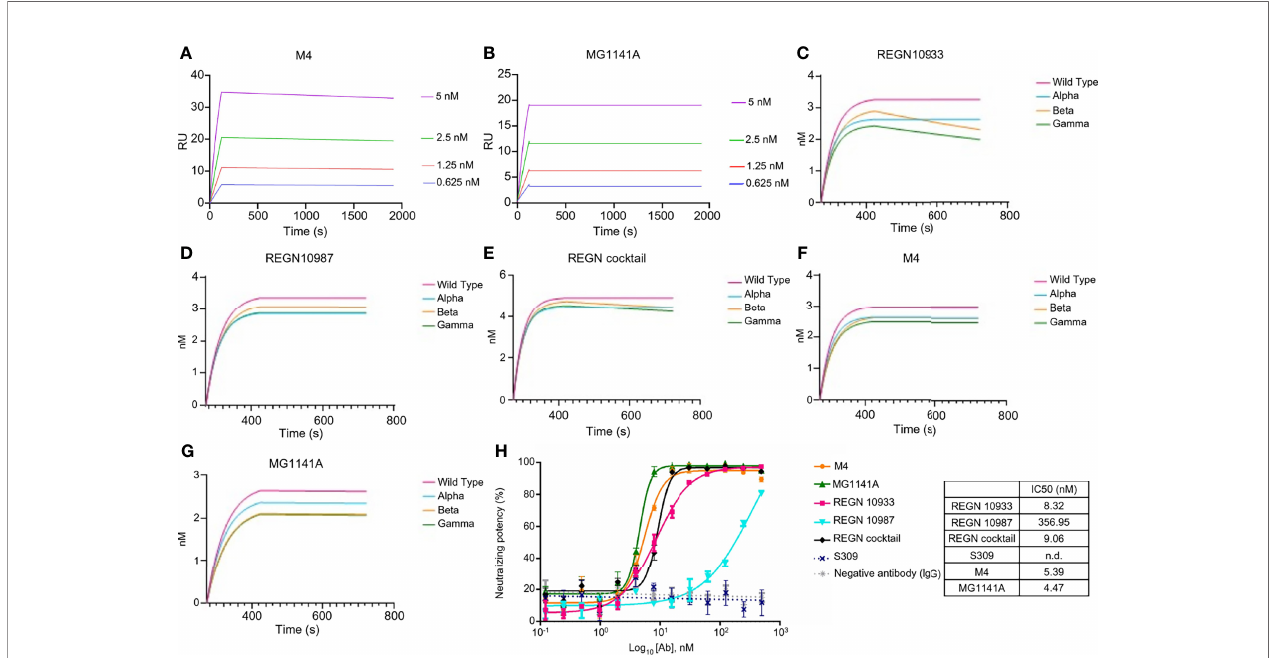
FIGURE 2 | Binding properties of anti-SARS-CoV-2 mAbs. (A, B) Binding sensorgrams of SARS-CoV-2 mAbs. Binding analysis of mAbs on a protein-A chip at 25°C using Biacore T-200. S protein was serially diluted (2-fold) from 0.3125 nM to 20 nM and was run on the chip for 180 s for association and 1,800 s for dissociation. Equilibrium dissociation constants ( k D ) were calculated from k off / k on ; at least four concentrations of S proteins were used. (C – G) Binding sensorgram of SARS-CoV-2 mAbs against SARS-CoV-2 proteins of alpha (United Kingdom), beta (South Africa), and gamma (Brazil) variants. Binding analysis of RBD variant captured on a Ni-NTA chip using an Octet Qke instrument. SARS-CoV-2 mAbs (125 nM) were run on the chip for 150 s for association and 300 s for dissociation. One representative graph out of two experiments that showed similar results is shown. (H) Competitive ELISA of mAbs with RBD against ACE2. Human ACE2 was coated on the ELISA plate, followed by incubation with a pre-incubated mixture of mAbs and RBD at 4°C overnight. The results are represented as a non-linear regression line, fi tted by GraphPad Prism 6. The competition of all mAbs was observed, except for S309; the results are represented by